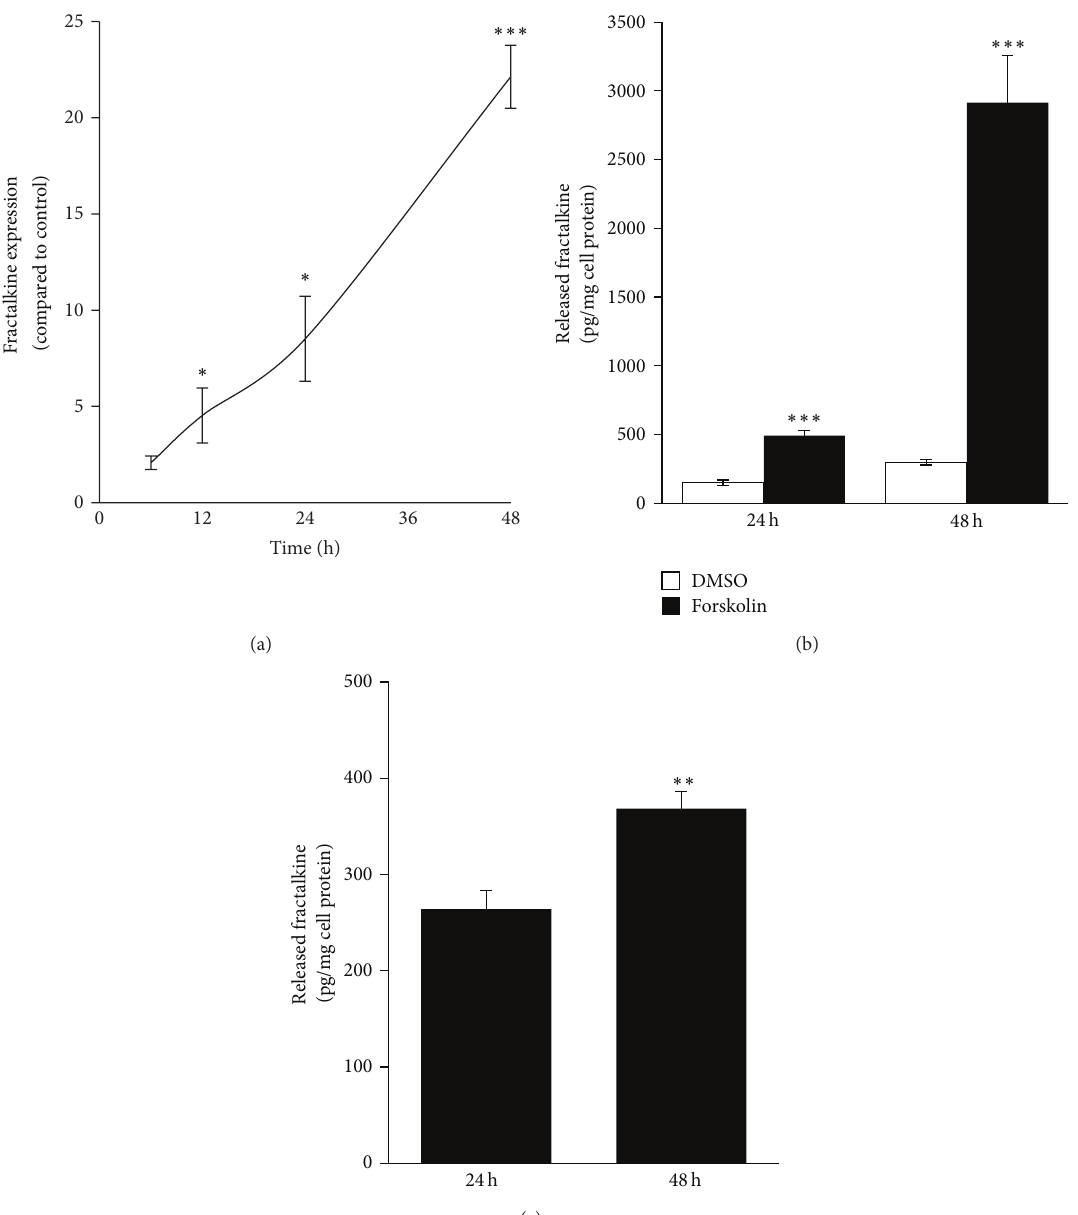
Figure 3: Analysis of fractalkine expression and release in the trophoblast cell line BeWo and primary term trophoblasts. Incubation with forskolin (20 𝜇 M) increased fractalkine mRNA expression in BeWo cells in a time dependent manner and showed a 22.1-fold ( ± 1.6) upregulation compared to control (DMSO, 0.2%) after 48h (a). Forskolin treatment of BeWo cells induced a 9.8-fold increase in secretion of soluble fractalkine compared to control after 48 h (b). In primary term trophoblasts secretion of soluble fractalkine increased between 24 h and 48 h incubation by 39.5% (c). Data in (a) and (b) are presented as mean ± SEM from three independent experiments performed in triplicate. Data in (c) are presented as mean ± SEM from four different trophoblast preparations. ∗ 𝑃 ≤ 0.05 , ∗∗ 𝑃 ≤ 0.01 , ∗∗∗ 𝑃 ≤ 0.001 .